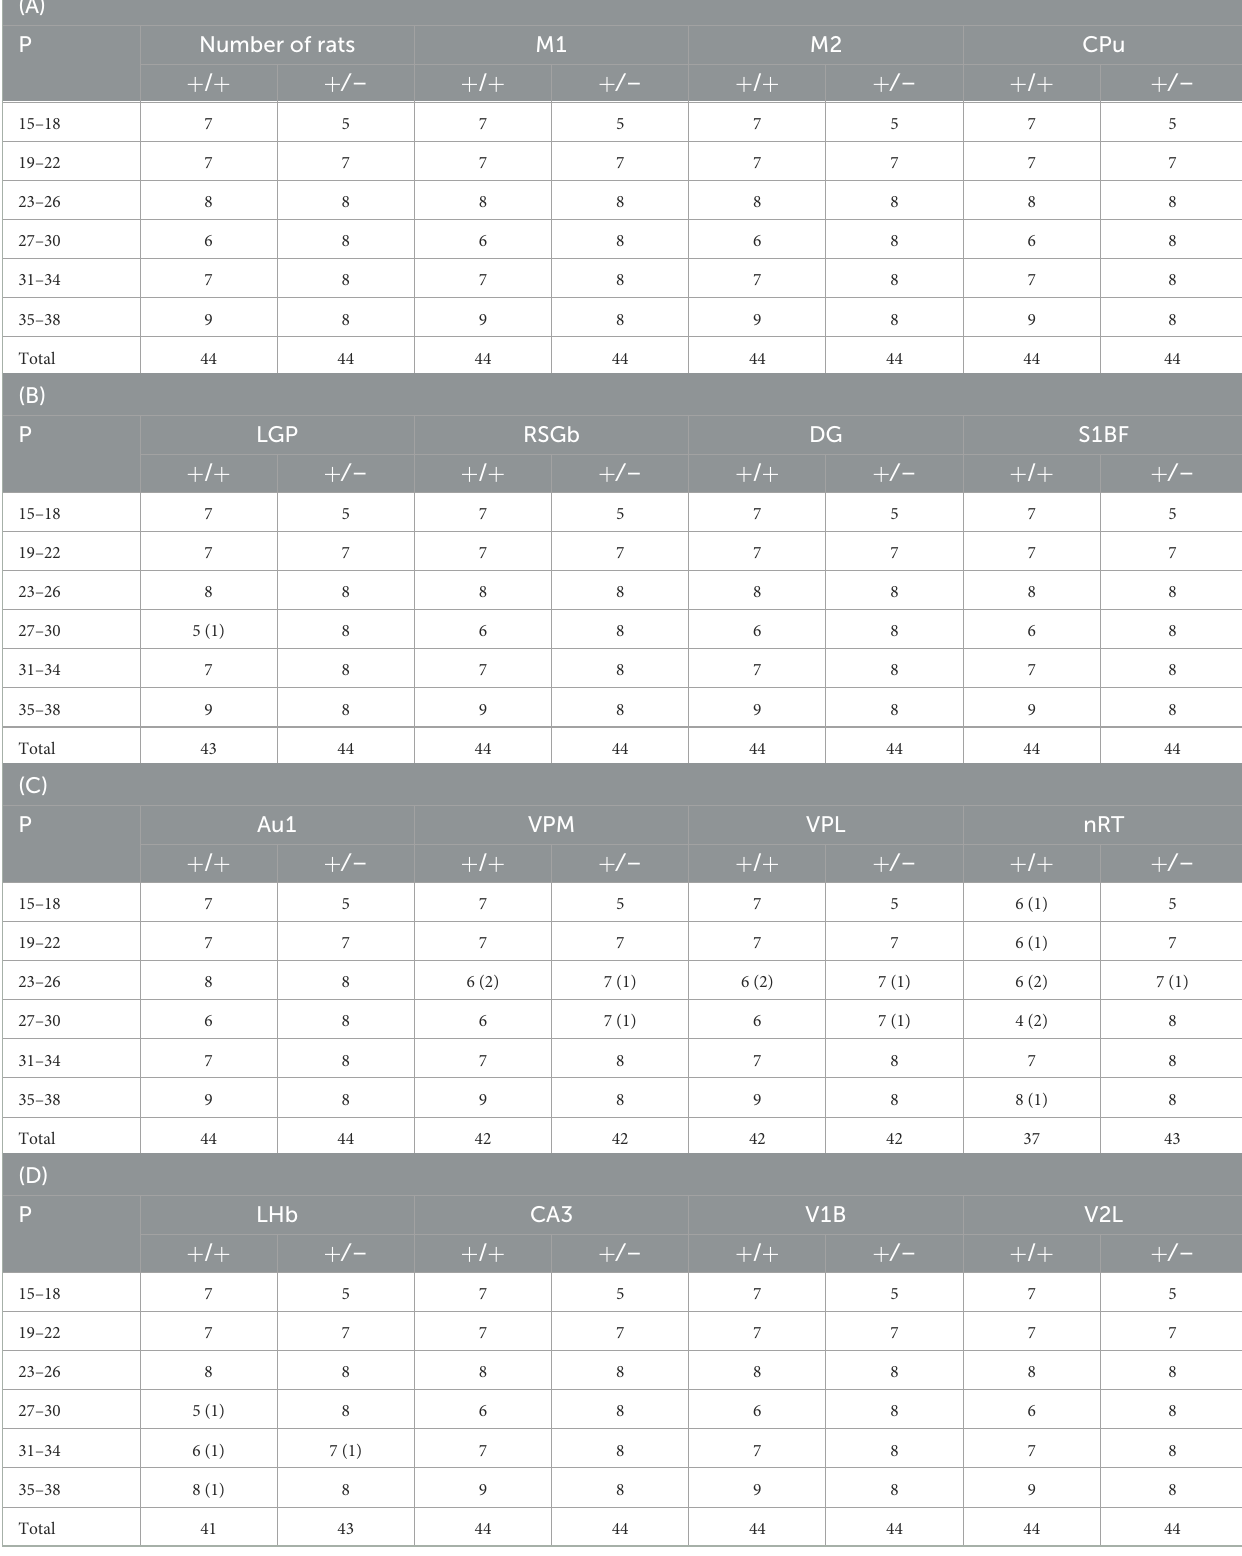
TABLE 1 Sample size for each postnatal day and each region of